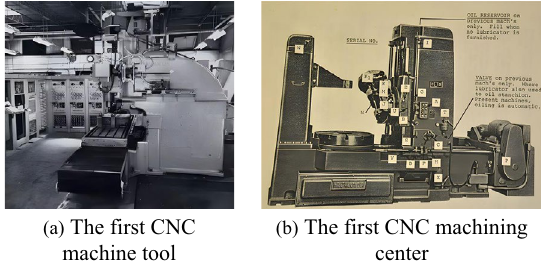
Figure 5 Typical machine tools in early digitization age